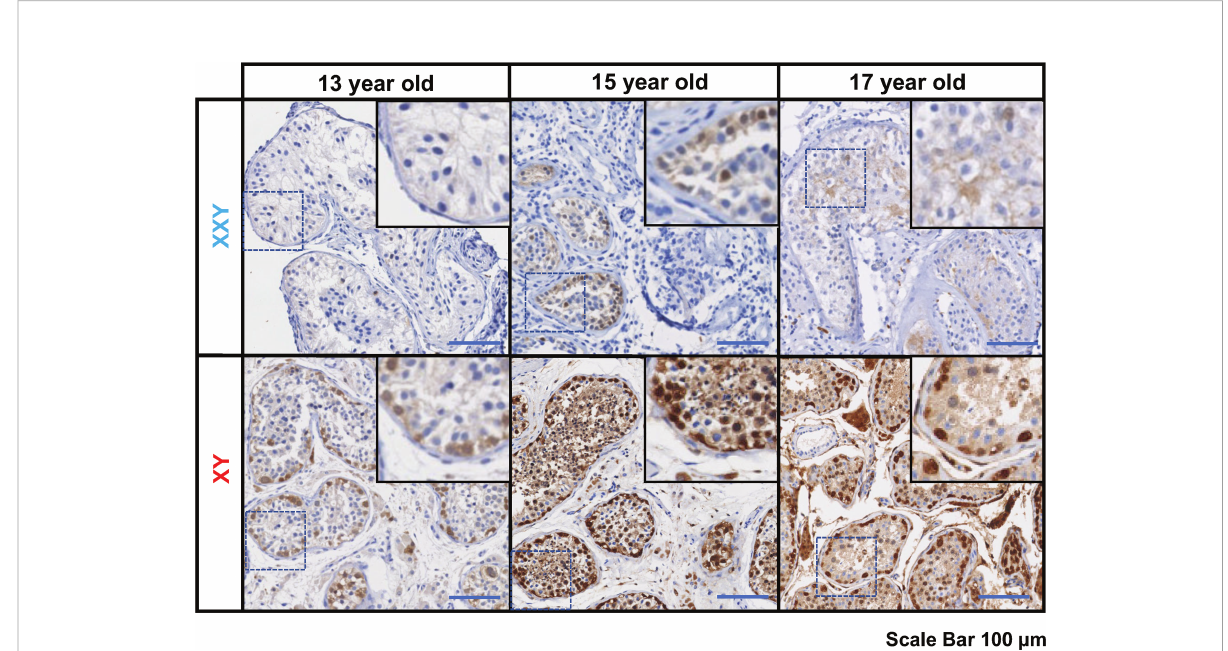
FIGURE 1 Immunostaining for undifferentiated spermatogonia marker UCHL1 (PGP 9.5), subjects ’ ages: 13, 15 and 17 years old. On the top panel, three Klinefelter patients included in the study. On the bottom panel, three aged-matched controls. Scale bar